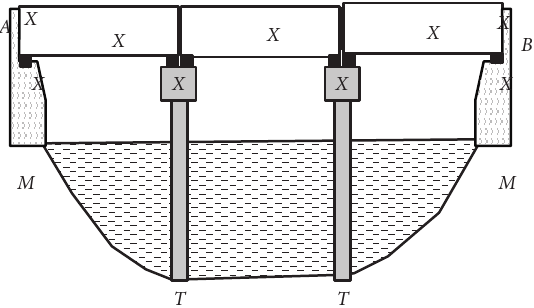
Figure 8: Simulation of cross section of Ben Noc bridge.